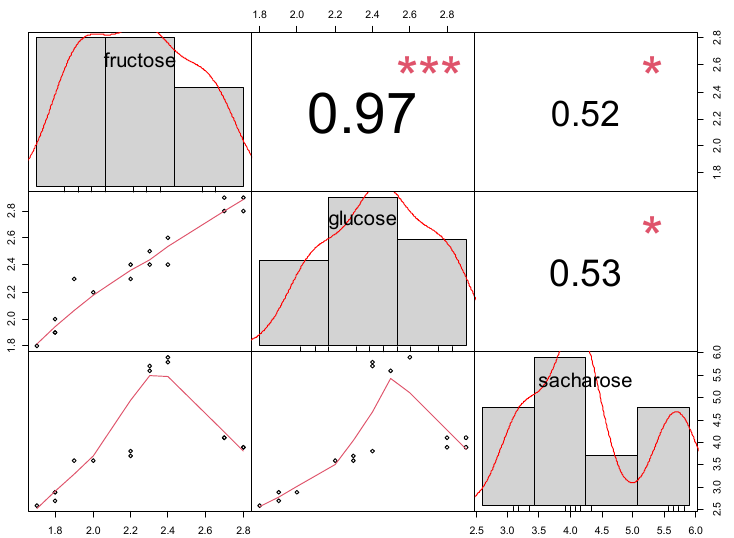
Figure 3. Correlation matrix of sugar concentration (mg kg − 1 dry matter). Note: *** ( p < 0.001), * ( p < 0.05).